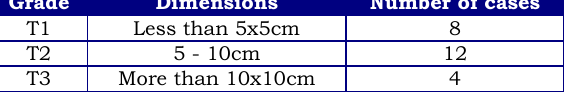
Table 1: Distribution of cases of SCT according to tumor size